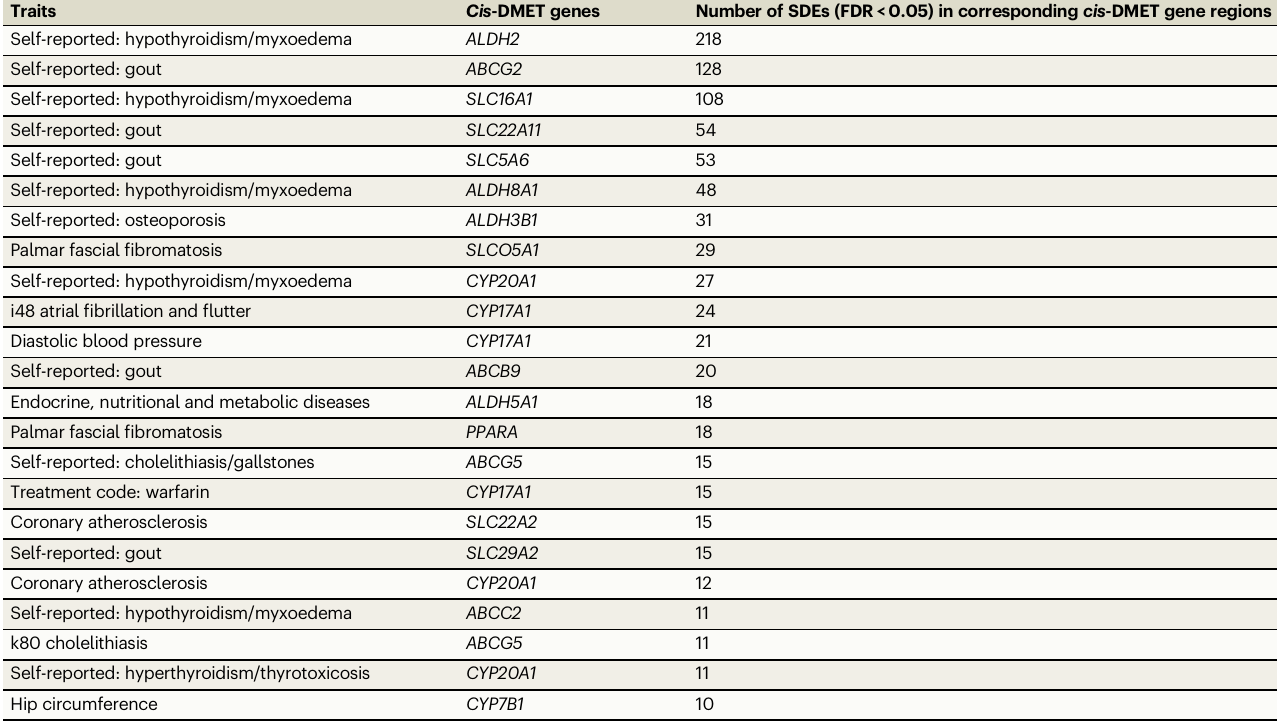
Traitswithatleast10SDEsinthecis-DMETgeneregionsareshown.TraitsaresortedbythenumberofSDEs.Treatmentcode ‘ levothyroxinesodium/thyroxineproduct ’ wasexcludedfromthetable due to information redundant